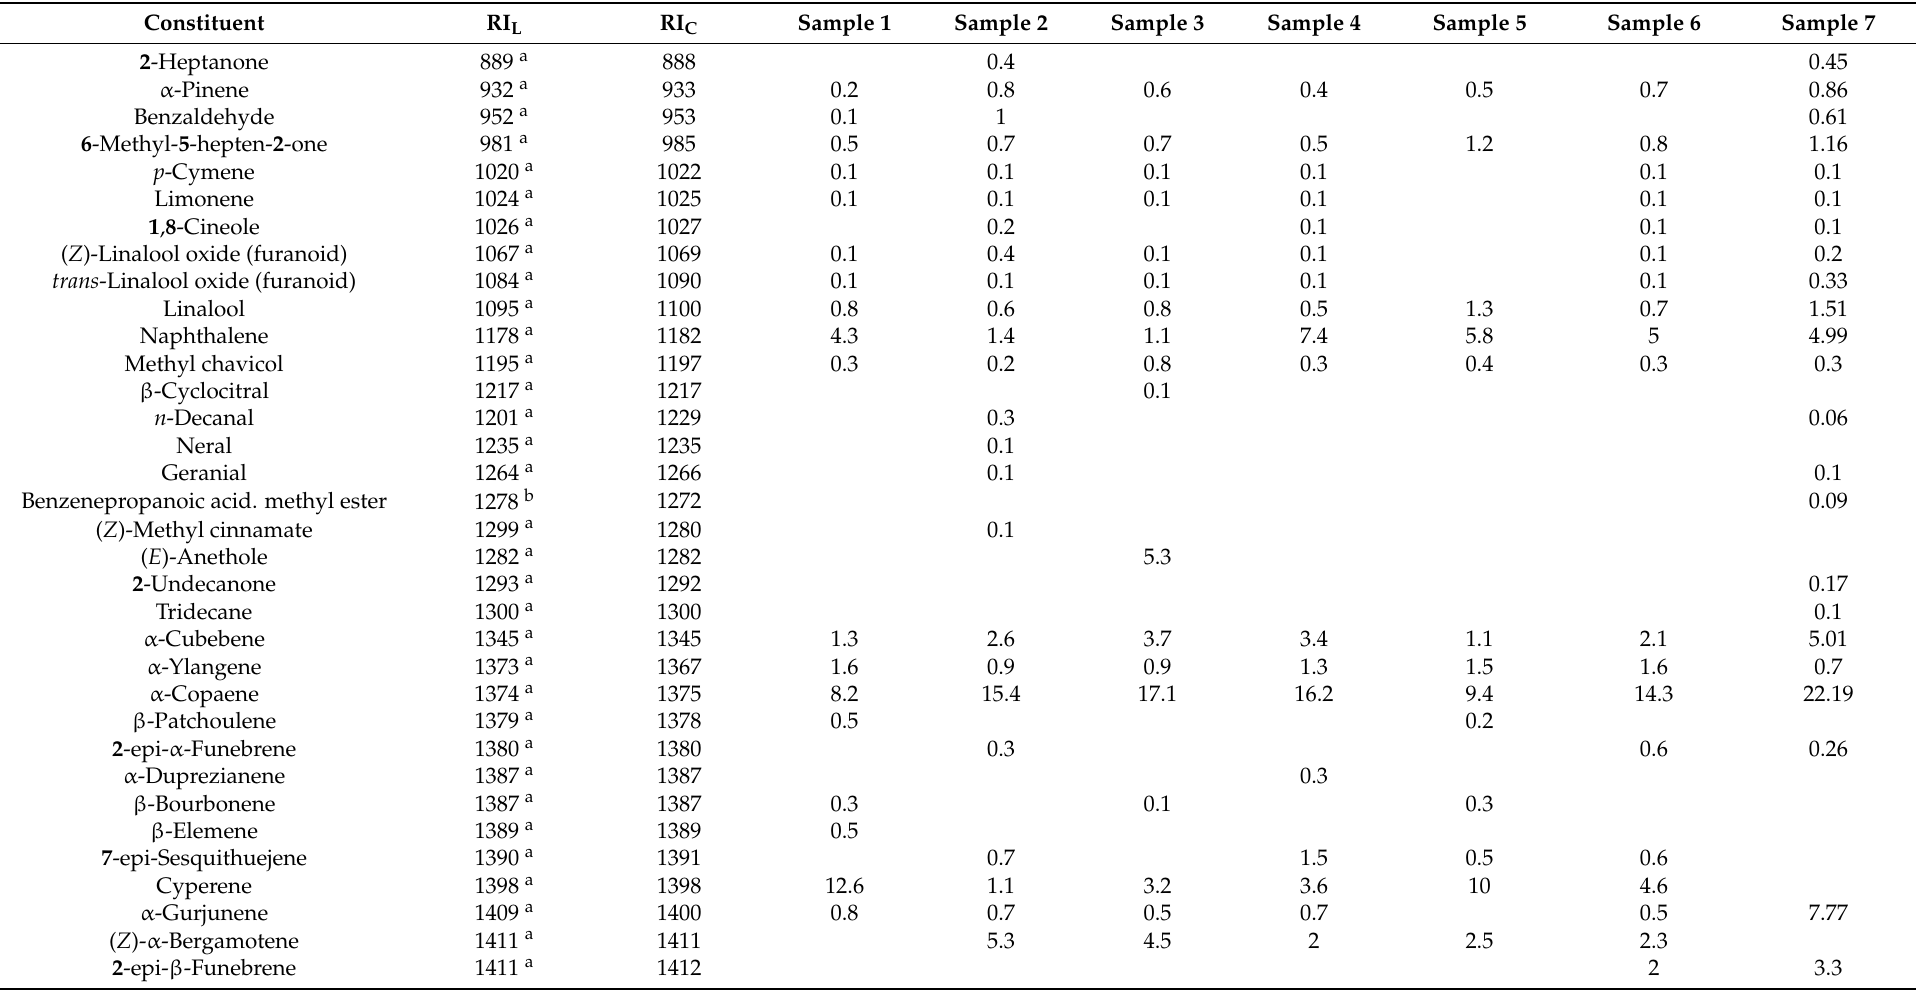
Table 1. Chemical composition (%) of volatile compounds identified in different propolis samples of Apis mellifera collected in the city of S ã o Jo ã o de Pirabas state of Par á